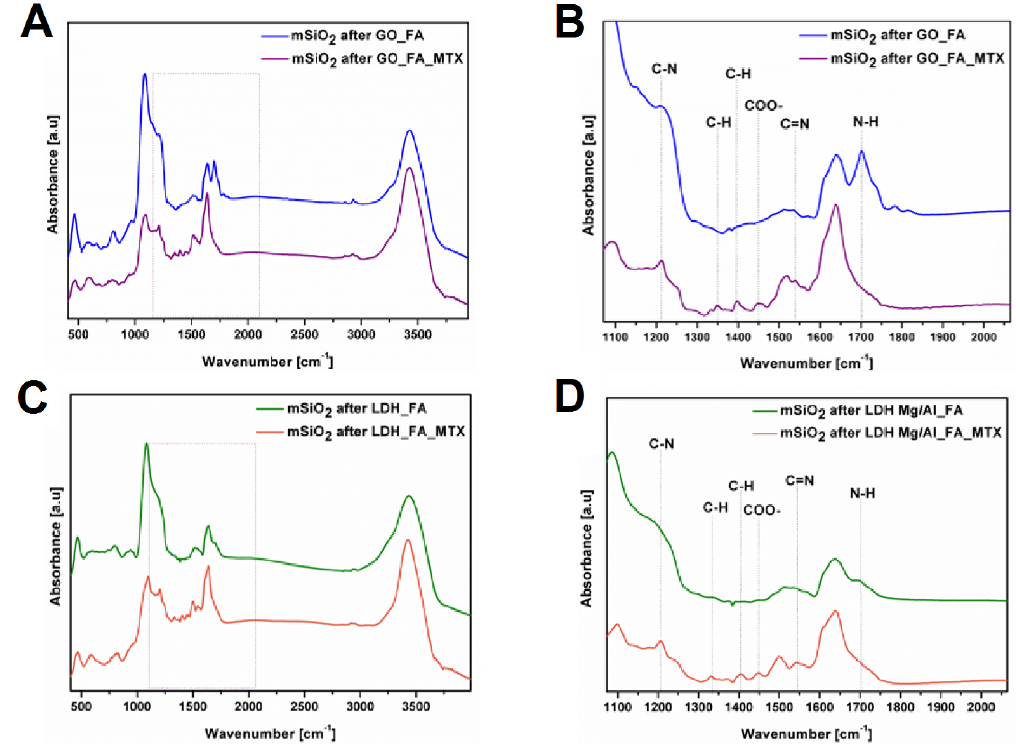
Figure 5. FTIR spectra of silica flakes functionalized with folic acid loaded with methotrexate (MTX): mSiO 2 after GO_FA ( A , B ) and mSiO 2 after LDH Mg / Al_FA ( C , D